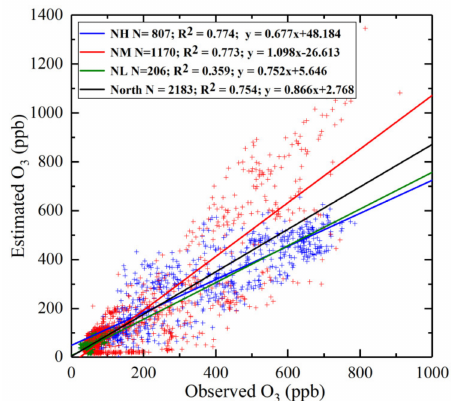
Figure 9. Scatter plots of LST ozone predictions versus ozone observations of CARIBIC flights in Northern Hemisphere from January 2018 to February 2019. The blue line indicates the results of CARIBIC at low latitude (NL), the red line indicates the results of CARIBIC at middle latitude (NM), the green line indicates the results of CARIBIC at low latitude (NL), and the black line indicates the results of CARIBIC in the Northern